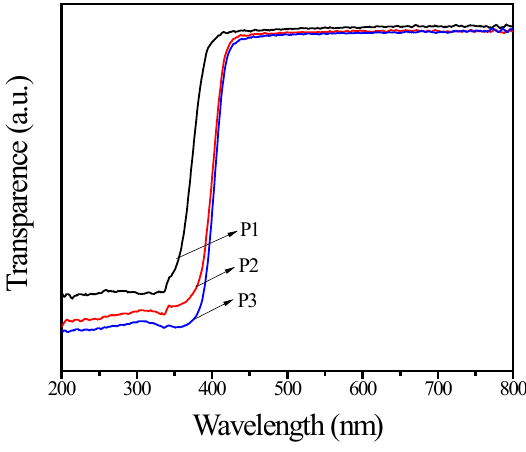
Figure 4. UV–vis spectra of the samples.